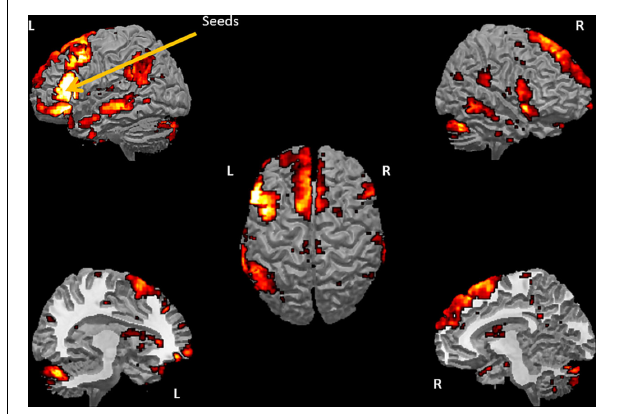
FIGURE 1 | Whole brain cluster map for the two seeds in Borca’s area. The figure presents the cluster map of the resting state analysis with seeds in the pars triangularis ( − 53 + 20 + 15) and the pars opercularis ( − 46 + 16 + 8) (Height threshold for peak voxels: p < 0 . 01 FDR and extension threshold for clusters: p < 0 . 01 FWE).